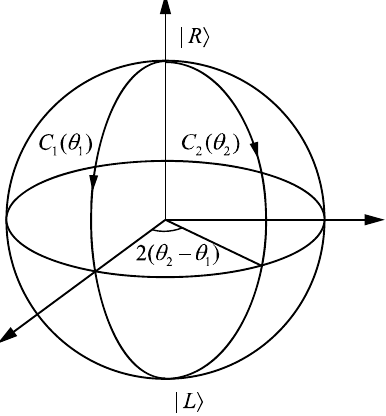
Fig. 1. Poincaré sphere representation of